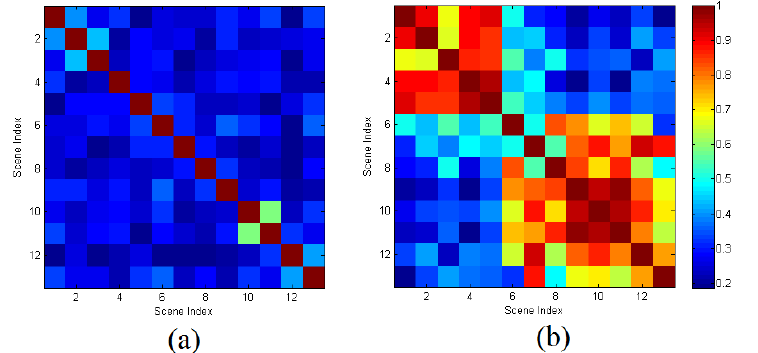
Fig. 2. Two examples of Coherence matrix of the PALSAR data stack on the tested distributed scatterers in Yellow River Delta, China. It shows the average coherence of all interferometric combination. (a) is a rice field, shows low coherence, (b) is the low bank of earth between rice-fields, which shows higher coherence and tendency of coherence loss affected by temporal